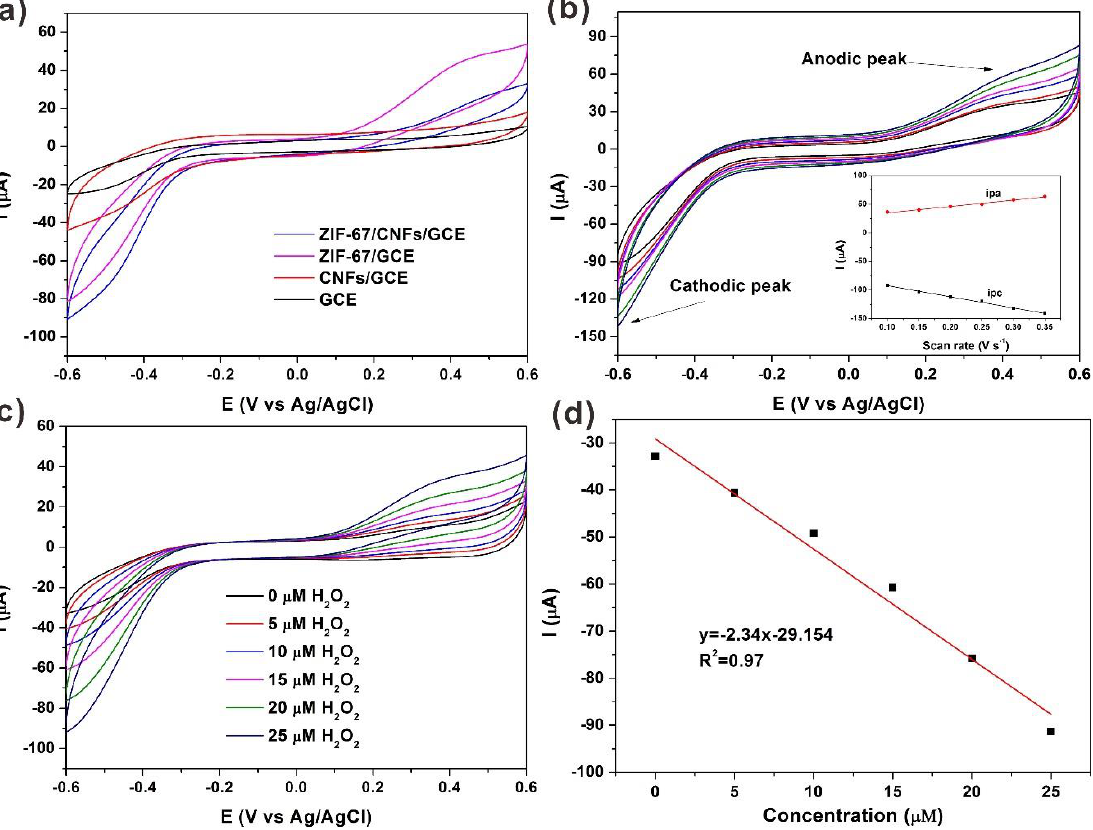
Figure 5. ( a ) CVs of different electrodes in 0.1 M NaOH solution containing 25 μ M H 2 O 2 ; ( b ) CVs of the ZIF-67/CNFs/GCE in 0.1 M NaOH solution at scan rates of 100, 150, 200, 250, 300, 350 mV s − 1 (from inner to outer), respectively, inset: plots of the corresponding anodic and cathodic peak currents vs. scan rate; ( c ) CVs of the ZIF-67/CNFs/GCE in 0.1 M NaOH solution with the presence of varied H 2 O 2 concentrations: 0, 5, 10, 15, 20, 25 μ M (scan rate: 100 mV s − 1 ); ( d ) the corresponding calibration curve.